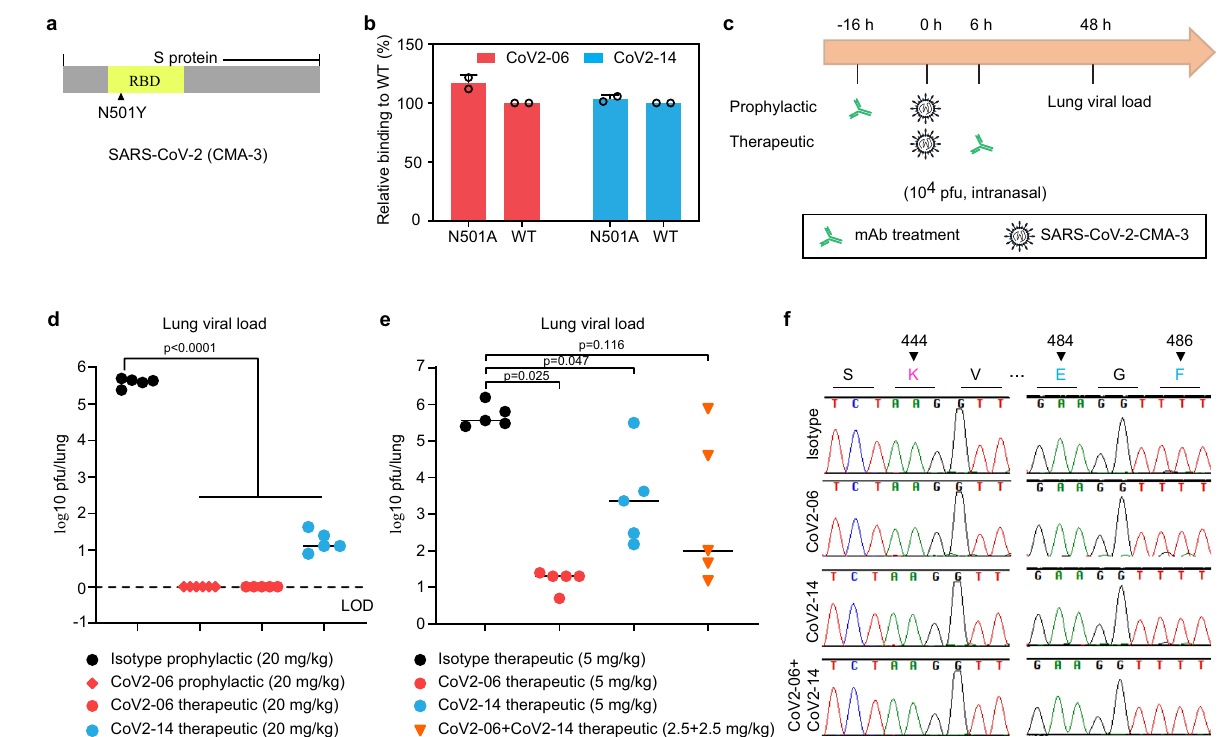
Fig. 8 Antibody protection of SARS-CoV-2 infection in mice. a A diagram showing the N501Y adapted mutation in the S protein RBD of the SARS-CoV-2 mouse-adapted strain (CMA-3). b ELISA binding of CoV2-06 and CoV2-14 to the WT sCoV2-RBD or the N501A mutant. Error bars indicate SD of duplicates wells. c Schematic diagram of prophylactic or therapeutic evaluations of the antibodies. d The infectious viral load in the lung of CoV-06- or CoV2-14-treated mice compared to that of isotype IgG1-treated mice. The dashed line indicates the limit of detection (LOD) of the assay. e The infectious viral load in the lung of mice with indicated treatment. The median levels of the lung viral load were shown as solid lines. N = 5 mice. Ordinary one-way ANOVA with Sidak ’ s multiple comparison test. f Representative sequencing results of the RBD regions of the viruses harvested from each treatment groups. The amino acid residues critical for antibody binding were indicated by